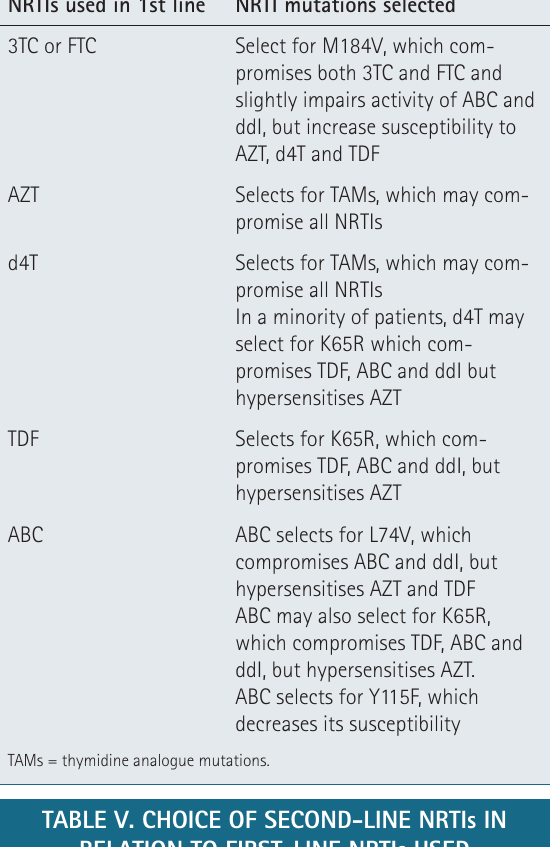
tAble iV. MutAtioNs selected by fiRst-liNe